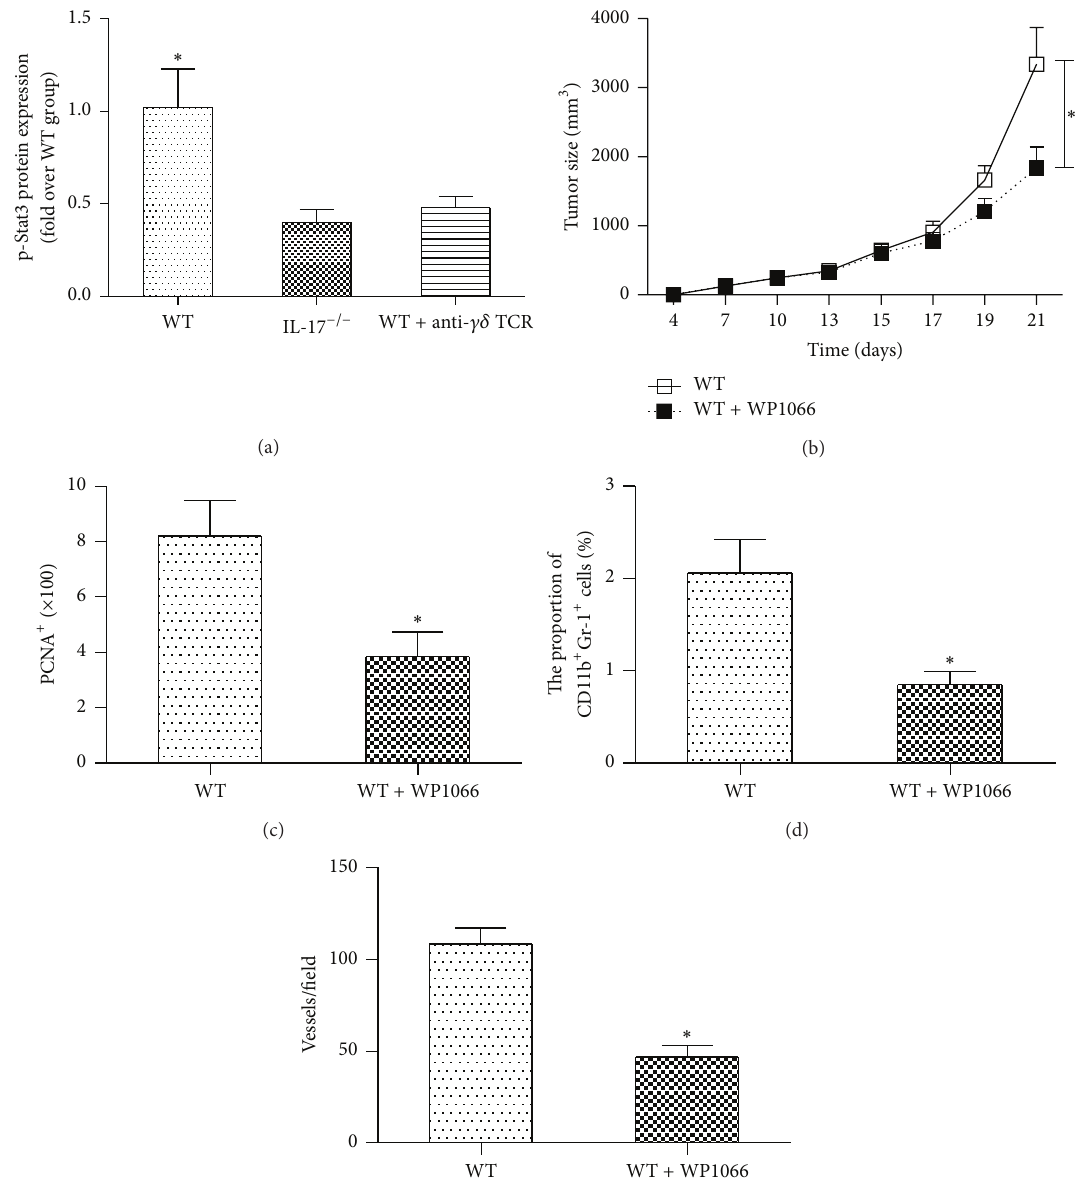
Figure 5: IL-17 promotes Stat3 activation. (a) Indicating p-Stat3 protein levels (analyzed by Western blot) in B16 tumor tissues from WT, WT + anti- 𝛾𝛿 TCR, and IL-17 −/− groups ( 𝑛 = 5 ). (b) Tumor growth in B16 tumor-bearing wild-type mice injected by oral gavage with WP1066 at 40mg/kg once per day (5 days on and 2 days off) ( 𝑛 = 5 ). (c) The number of PCNA + cells in tumor tissues from B16-F10 tumor-bearing wild- type mice 2 weeks after inoculation ( 𝑛 = 5 ). (d) CD11b + Gr-1 + MDSCs in tumor samples of B16-F10 tumor-bearing wild-type mice ( 𝑛 = 5 ). (e) The number of blood vessels in tumor tissues from B16-F10 tumor-bearing wild-type mice ( 𝑛 = 5 ). The data show means ± SEM of tumor size and are representative of three independent experiments. ∗ 𝑃 < 0.05